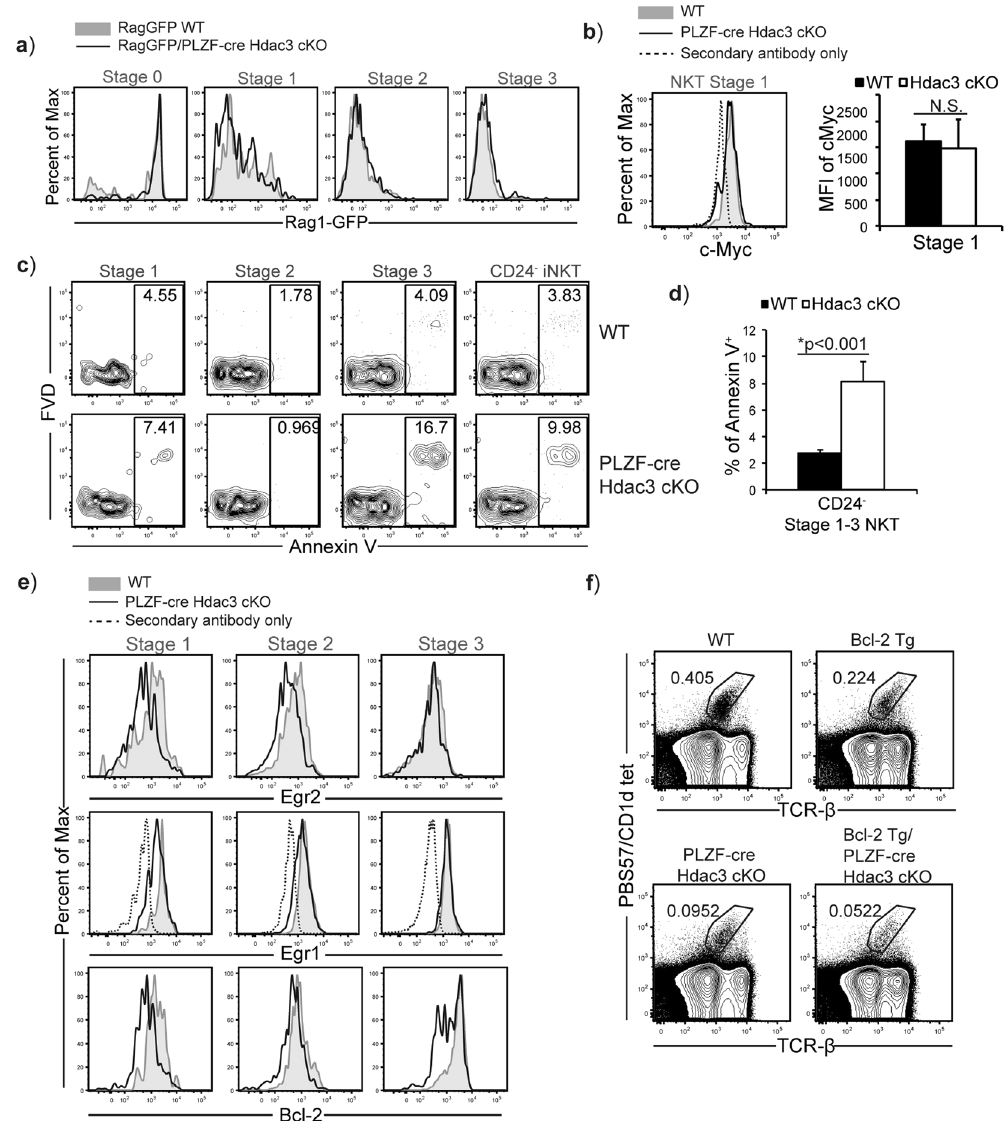
Figure 3. Normal proliferation but increased cell death in Hdac3-deficient iNKT cells. ( a ) FACS analysis of GFP expression in iNKT cells at their developmental stages (Stage 0–3) in Rag1-GFP (WT) (grey filled) and Rag1-GFP/PLZF-cre Hdac3 cKO (black line). Data is representative of at least 4 mice/genotype from 4 independent experiments. ( b ) Intracellular expression of c-Myc in Stage 1 iNKT cells of WT (grey filled) and PLZF-cre Hdac3 cKO (black line); secondary antibody only control is shown with dashed line. Data is representative of at least 3 mice/genotype from at least 3 independent experiments. Quantification of average MFI of c-Myc from Stage 1 iNKT cells of WT (black bar) and PLZF-cre Hdac3 cKO (white bar) mice. Data is calculated from 5 WT and 3 PLZF-cre Hdac3 cKO mice. Statistical analysis was performed using a Student t test. Means ± SEM. ( c ) Representative frequency of apoptotic Stage 1 (CD24 − CD44 lo NK1.1 − ), Stage 2 (CD24 − CD44 hi NK1.1 − ), and Stage 3 (CD24 − NK1.1 + ). iNKT cells in WT (top) and PLZF-cre Hdac3 cKO (bottom) mice using Annexin V + and Fixable Viability Dye + (FVD). Data is representative of at least 9 mice per genotype from 7 independent experiments. ( d ) Quantification of frequency of apoptotic Annexin V + CD24 − iNKT cells. Average was calculated from 15 WT (black bars) and 9 PLZF-cre Hdac3 cKO (white bars) mice from at least 7 independent experiments. Statistical analysis was done using a Student t test. Means ± SEM. ( e ) Expression of Egr1, Egr2 and their target Bcl-2 in Stage 1–3 iNKT cells of WT (grey filled), PLZF-cre Hdac3 cKO (black line) mice. Secondary antibody (fluorescent labeled) only control (dashed) is shown for Egr1 where unlabeled cells in WT, PLZF-cre Hdac3 cKO, Bcl-2 Tg and Bcl-2 Tg/ PLZF-cre Hdac3 cKO mice. Data is representative of at least 3 mice/genotype from 3 independent experiments. Staining and gating for each iNKT cell stages